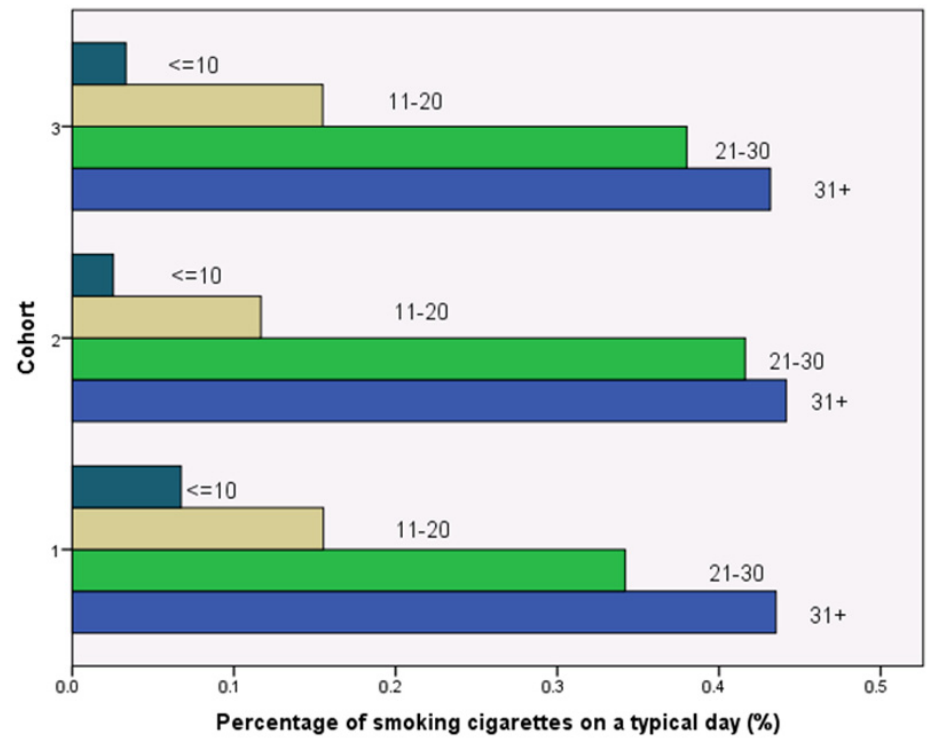
Figure 2. Randomness of Gender Distribution.